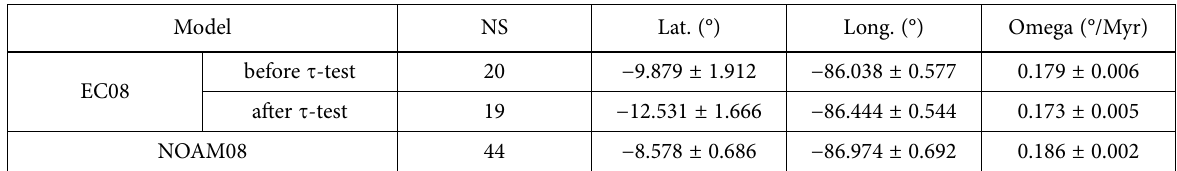
Table 2. Estimated absolute Euler poles of